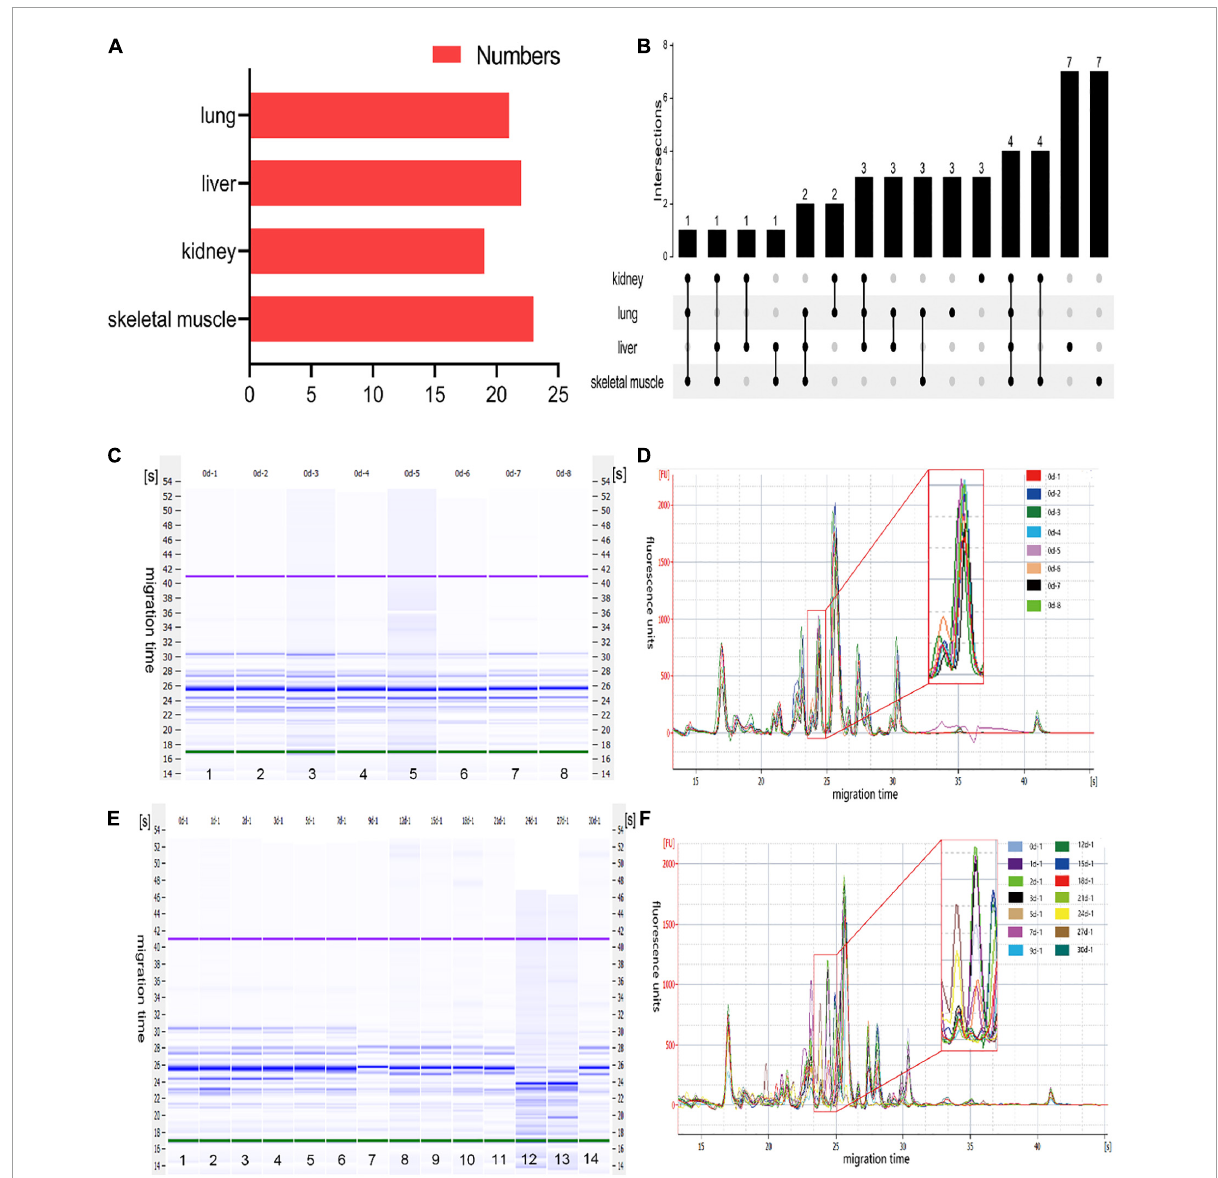
FIGURE2 The characteristics of polypeptide fragments in different organs at different times after death. (A) The numbers of polypeptide fragments in different organs. (B) Co-expression analysis of polypeptide fragments in different organs. (C) The gel-like image of polypeptide fragments in skeletal muscle at the same time points after death. This figure is the simulated gel electrophoresis figure automatically given by Agilent 2,100 Bioanalyzer according to the molecular weight. Lanes 1–8 represent the gel diagram of eight skeletal muscle samples in 0 day after death. The migration time (s) is set on the side of the gel image. The purple bands at the top and the green bands at the bottom are the upper/lower ladder, which is the standard, respectively. The remaining blue bands are the detected protein fragments. The shade of the blue band represents the content of each protein fragment. (D) The electropherogram of skeletal muscle at the same time points after death in the microfluidic chip electrophoresis (LoaC) system. Multi-peak spectrums overlaid of different rats at the same time points after death, and there was no significant difference in peak height and number of peaks in the superposition of multi-peak spectra at the same time point after death of different rats. It is worth noting that there is a peptide peak around 24.5s in all samples at the same time point after death. (E) The gel-like image of polypeptide fragments in skeletal muscle at different time points after death. This figure is the simulated gel electrophoresis figure automatically given by Agilent 2,100 Bioanalyzer according to the molecular weight. Lanes 1–14 represent the gel diagram of 14 time points of skeletal muscle samples within 0–30 days after death. The migration time (s) is set on the side of the gel image. The purple bands at the top and the green bands at the bottom are the upper/lower ladder, which is the standard, respectively. The remaining blue bands are the detected protein fragments. The shade of the blue band represents the content of each protein fragment. (F) The electropherogram of skeletal muscle at different time points after death in the microfluidic chip electrophoresis (LoaC) system. The peak heights showed significant differences and a new peptide peak appears near 24.5 s by comparing multi-peak spectrums at different time points after